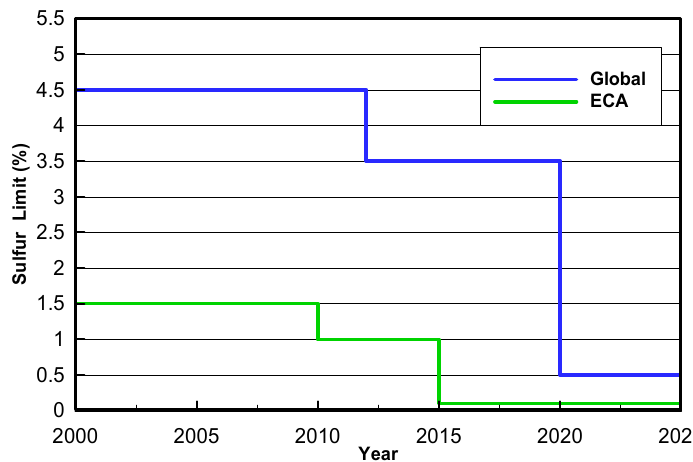
Figure 1. MARPOL Annex VI requirements of sulfur limits (SO x ) [6].